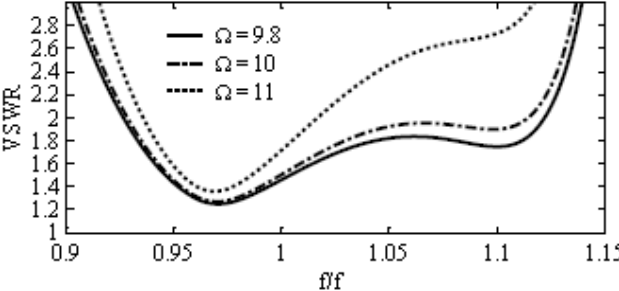
Figure 7: VSWR for 3-element CCLAs backed with a ground plane. The height above the plane is d = 1.0384 b